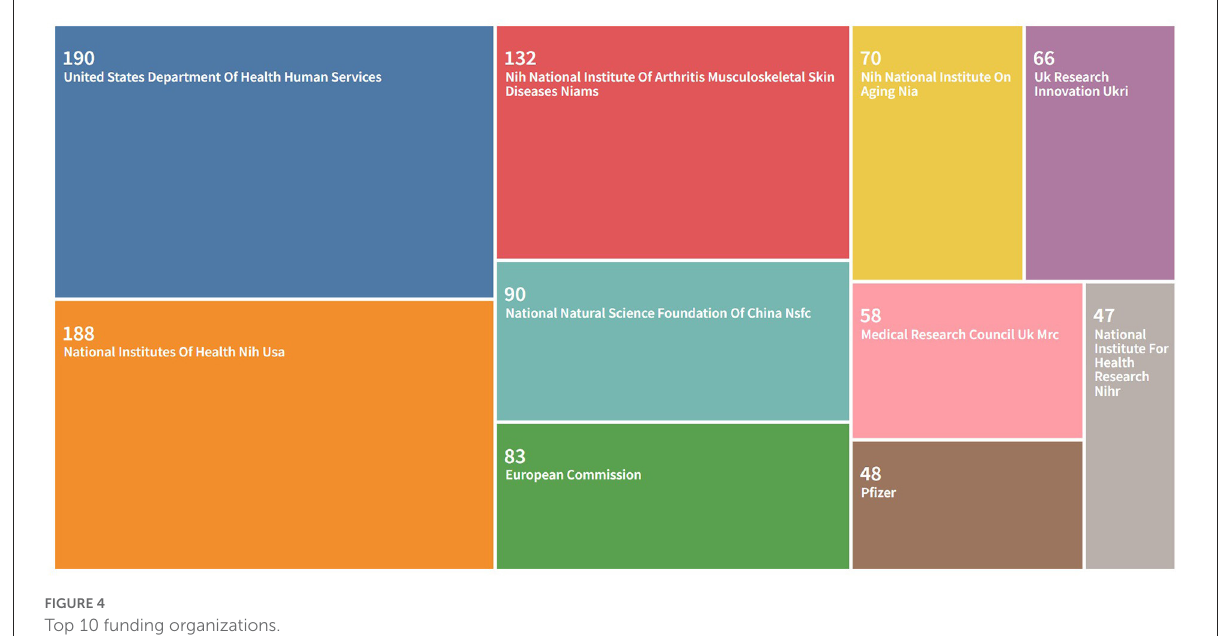
FIGURE4 Top 10 funding